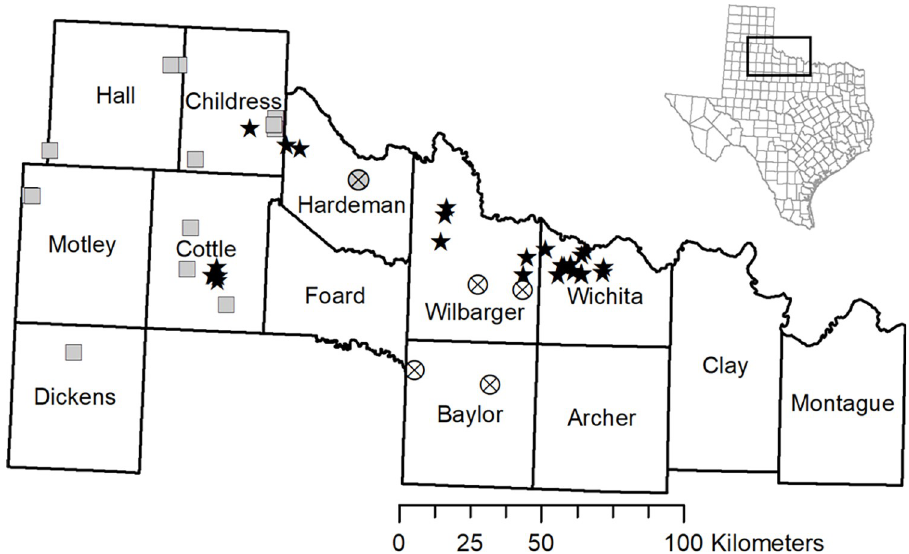
Fig 1. Map of kangaroo rat samples used in this study. Filled stars indicate contemporary Dipodomys elator samples whereas circles with an ‘x’ are historical D . elator samples. Twenty-eight historical samples in Hardeman are represented by one filled circle with an ‘x’. Filled squares represent D . ordii samples used in the study. Note the contemporary sampling gap located in Foard County, most of Hardman County, and in south Wilbarger County. Trapping restrictions and topography prevented collections in those regions. D . elator is thought to be extirpated in all counties except Cottle, Childress, Hardeman, Wilbarger, and Wichita counties. Map was constructed using ArcMap v10.8.1 and the 1:1,000,000-Scale National Boundaries of the United States data from the USGS EROS (Earth Resources Observatory and Science) Center).